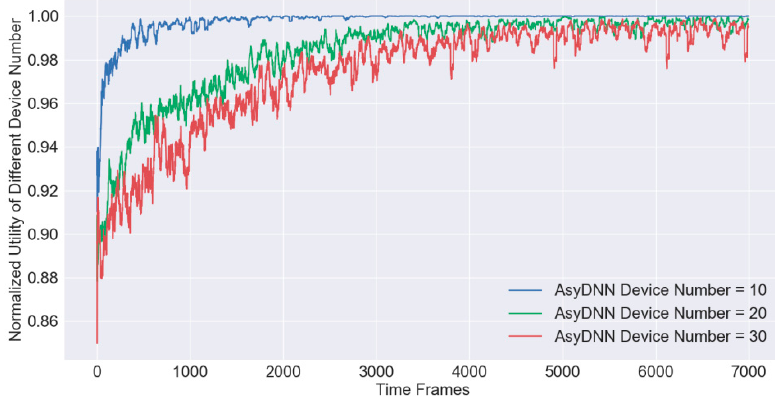
Figure 8. Scalability analyses of training processes for the IRAO algorithm.